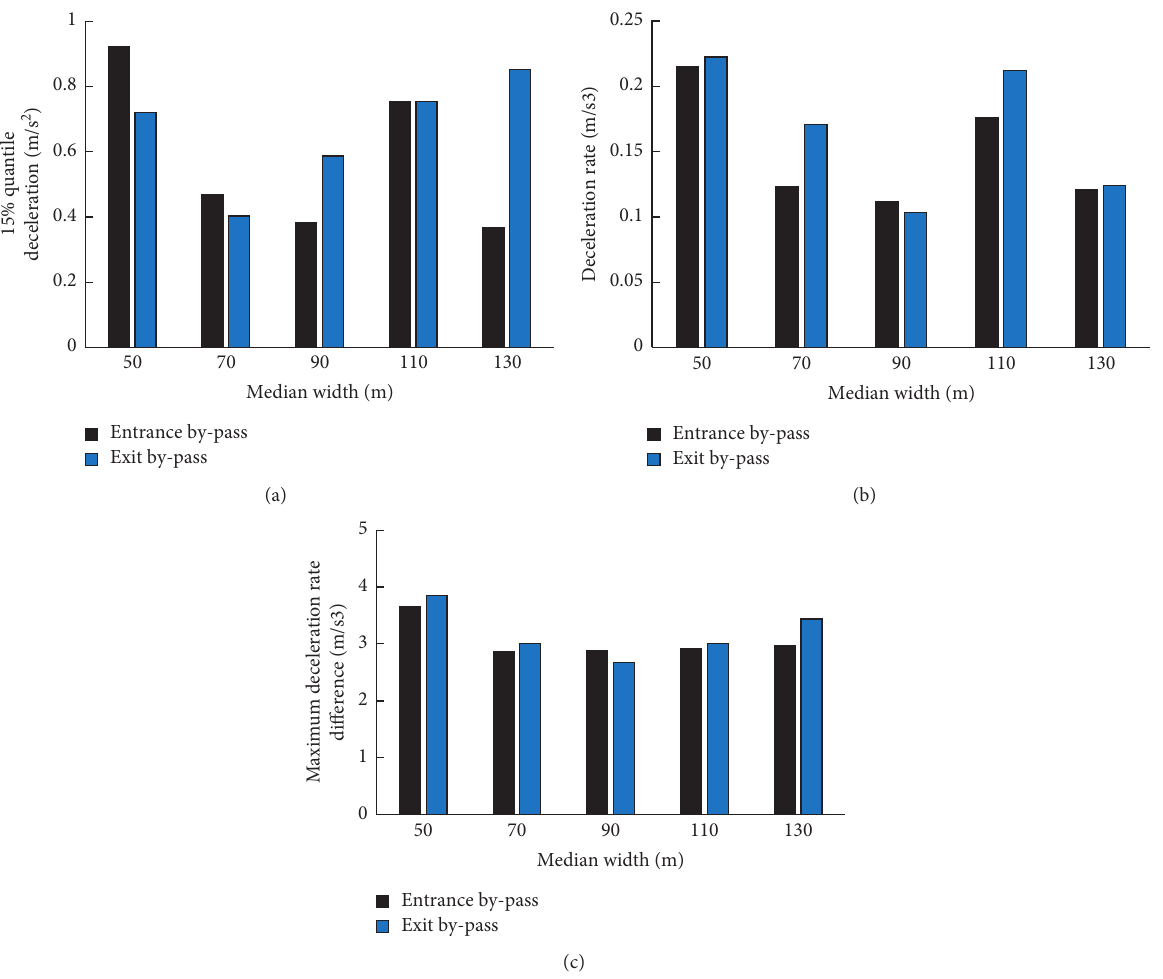
Figure 4: Deceleration parameters’ change with median width: (a) 15% quantile deceleration; (b) deceleration rate; (c) maximum deceleration rate difference.